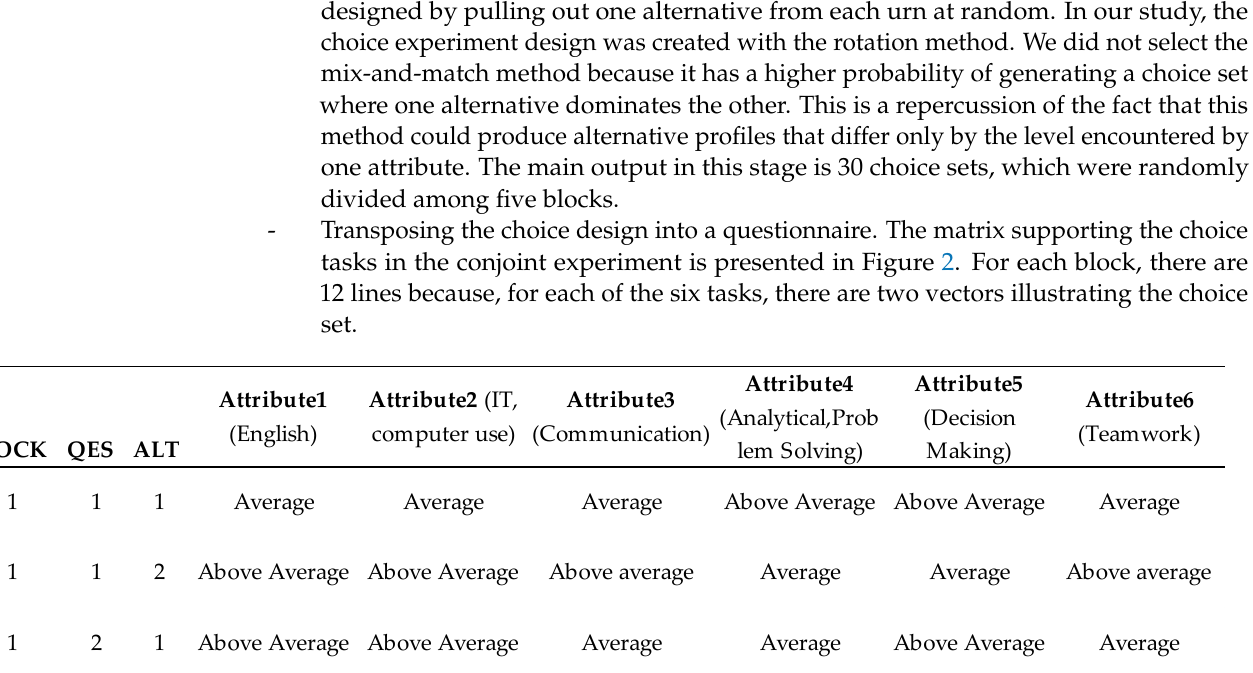
select between this profile and the one detailed in the second row.